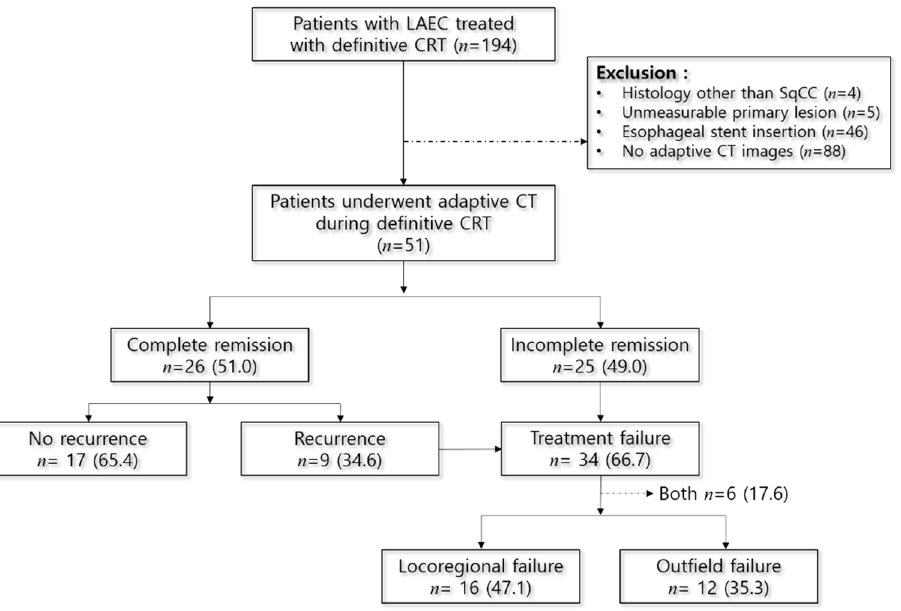
Figure 2. Flow chart capturing treatment outcomes according to the clinical course. LAEC, locally advanced esophageal cancer; CRT, chemoradiotheray; SqCC, squamous cell carcinoma.